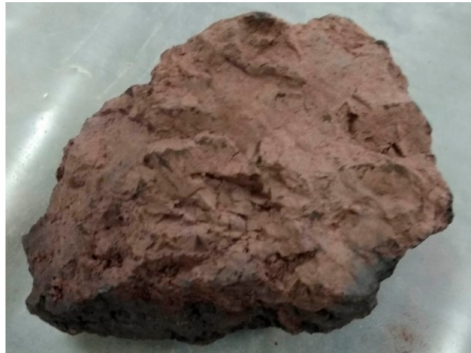
Figure 1. Sample of manganese ore rock from the Zhaksy deposit.